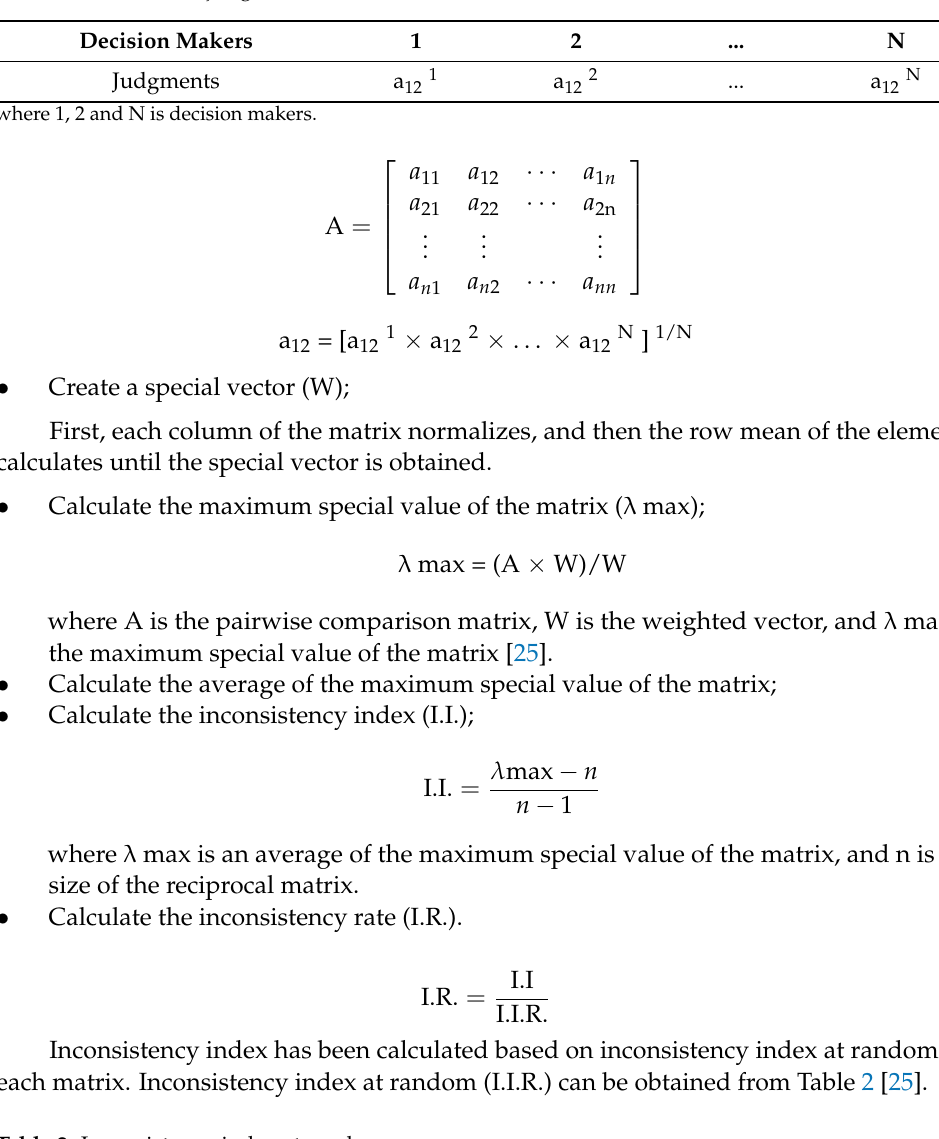
Table 2. Inconsistency index at